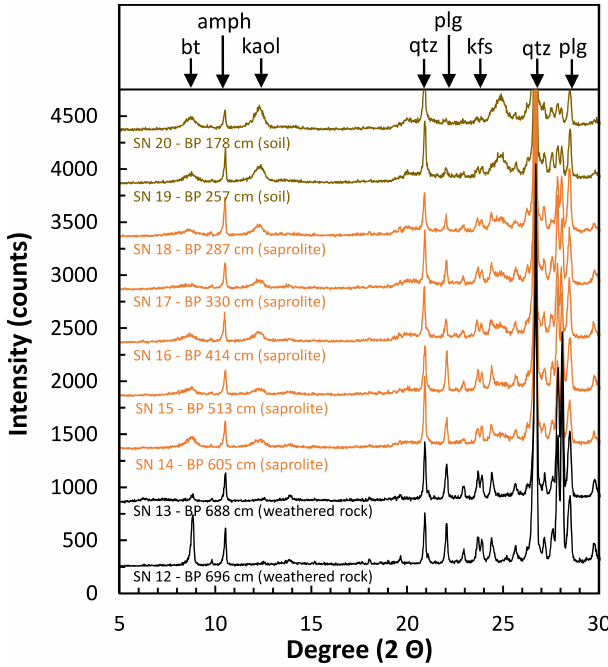
Figure B1. X-ray diffraction (XRD) patterns of bulk soil, bulk saprolite, and bulk bedrock stacked on top of each other. Major reflections of primary minerals (bt = biotite, amph = amphibole, qtz = quartz, kfs = K-feldspar, plg = plagioclase) and secondary minerals (kaol = kaolinite) are